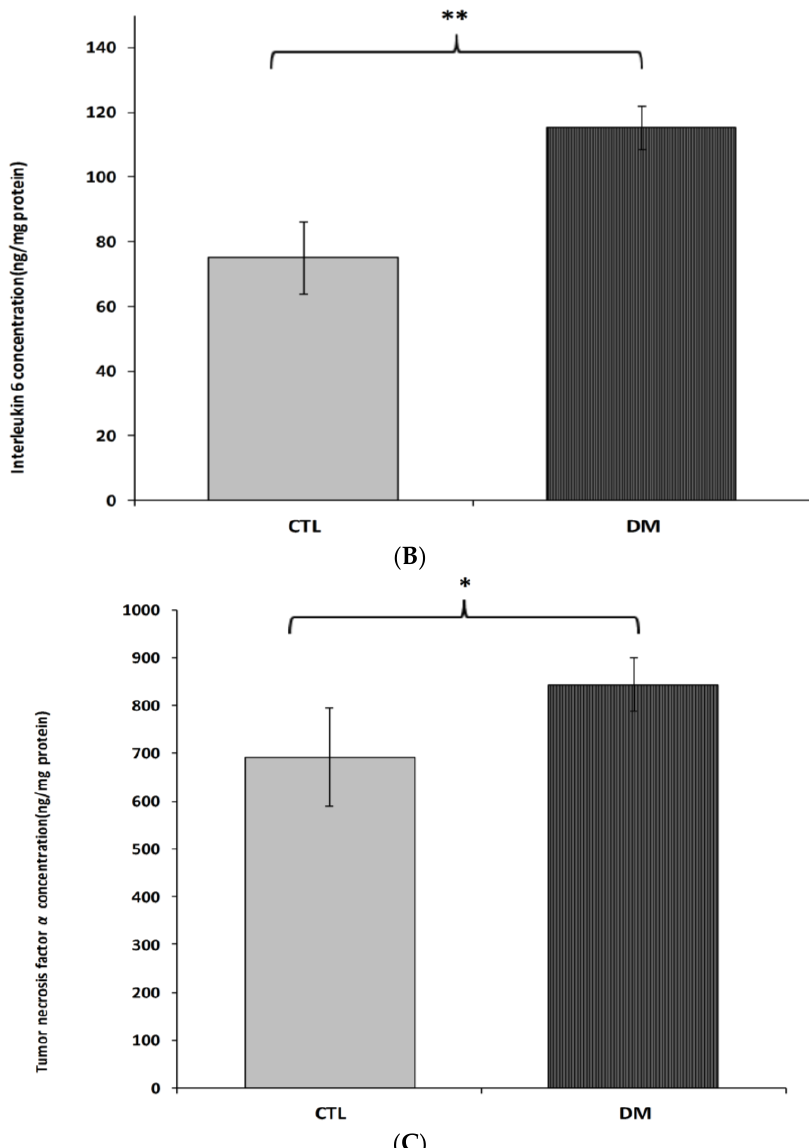
Figure 4. Levels of IL-1 β ( A ), IL-6 ( B ) and TNF- α ( C ) in brain prefrontal cortex of diabetic mice. Data are expressed as mean ± SEM ( n = 6). CTL: Control mice, DM: Diabetic mice; * p < 0.05, ** p < 0.01 vs.